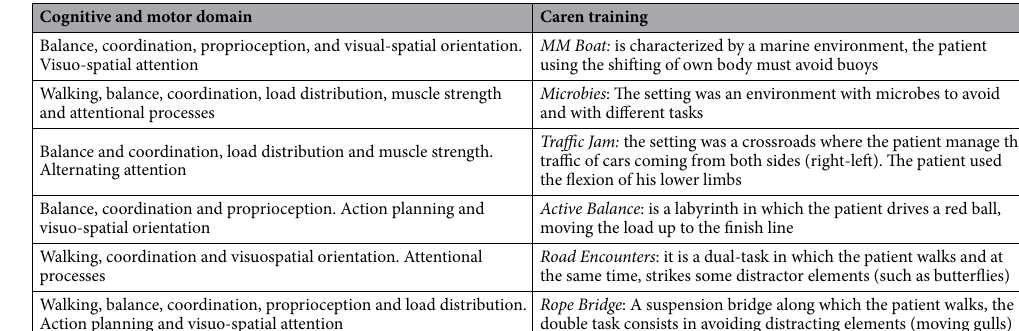
MM Boat: is characterized by a marine environment, the patient using the shifting of own body must avoid buoys Microbies : The setting was an environment with microbes to avoid and with different tasks Traffic Jam: the setting was a crossroads where the patient manage the traffic of cars coming from both sides (right-left). The patient used the flexion of his lower limbs